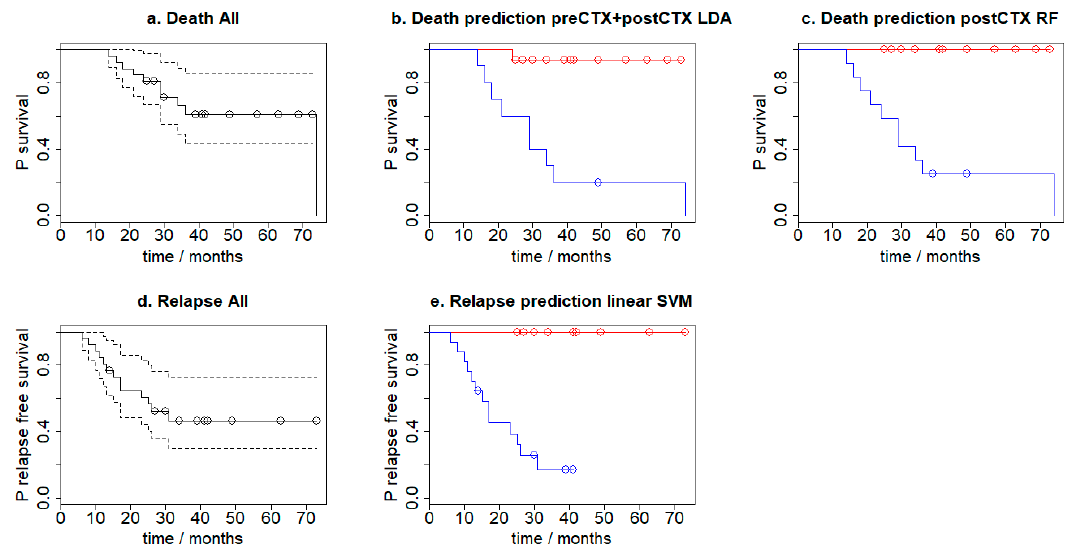
Figure 4. Kaplan–Meier plots for ( a ) overall survival, overall survival according to leave-one-out cross-validation prediction using the ( b ) preCTX+postCTX LDA model ( p = 0.00023) ( c ) postCTX RF model ( p = 0.000197), ( d ) progression-free survival and ( e ) according to leave-one-out cross-validation prediction using the linear SVM model ( p = 0.000387). In ( b ) and ( c ) red indicates those predicted to die, whilst blue are those predicted to live. In ( e ) red indicates those patients who are predicted to relapse, whilst blue are those predicted to not relapse.